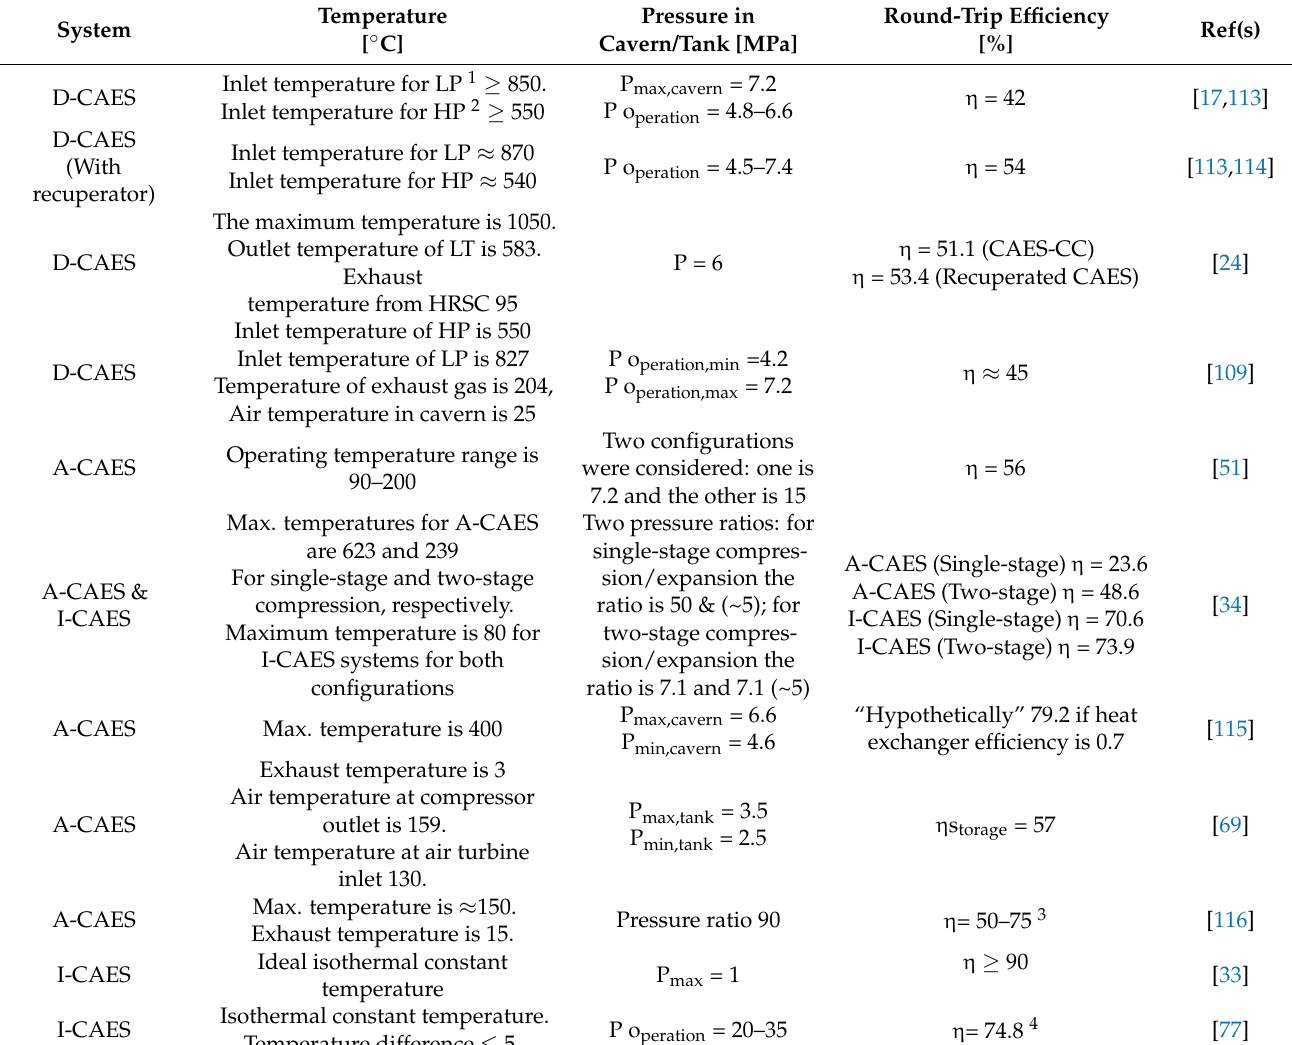
Table 4. Operating details of selected CAES